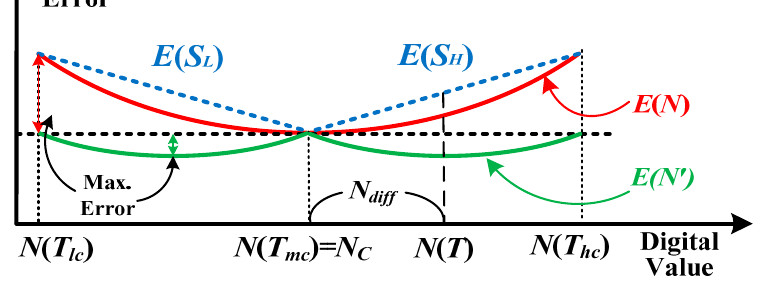
Figure 7. Error curves versus temperature with and without and the linearization.